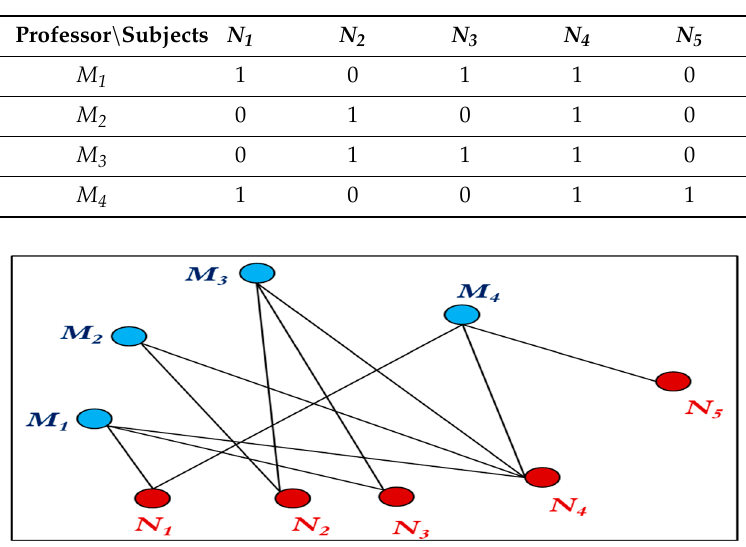
Figure 21. Bipartite graph of four professors and five subjects.